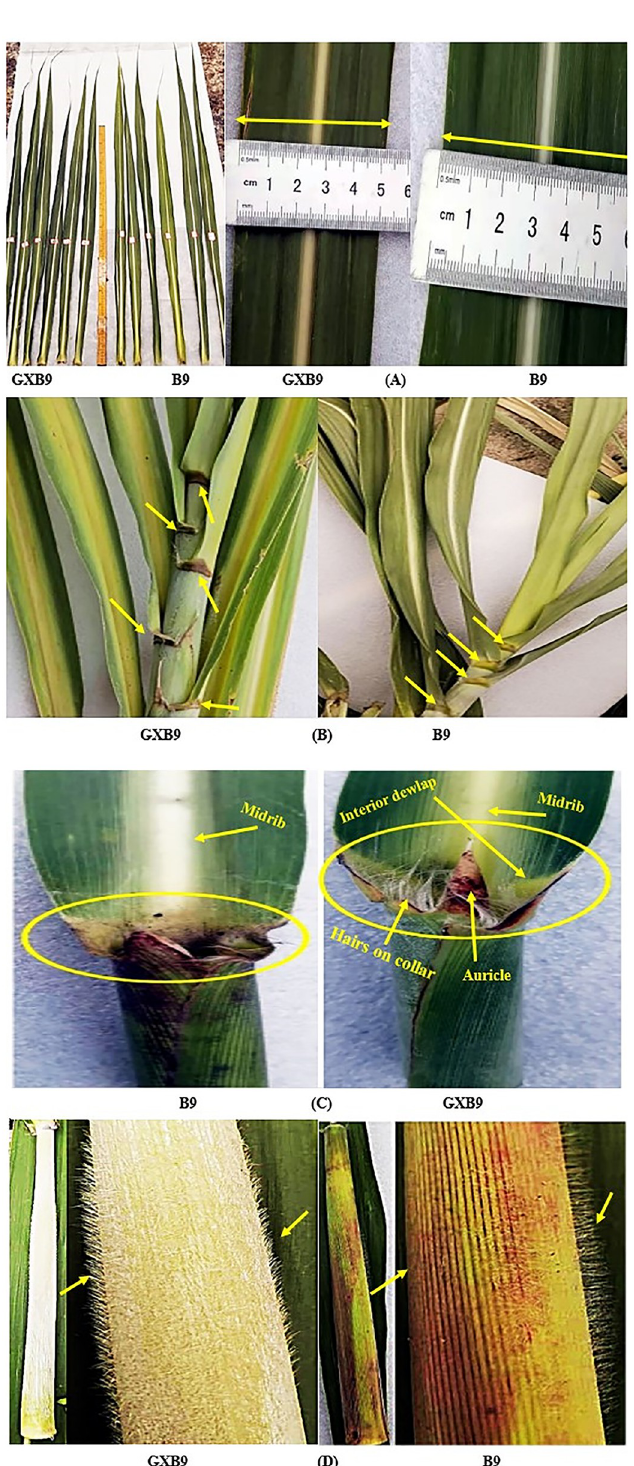
Fig 5. Leaf structures in GXB9 and B9. A , leaf length and width; B , ligule color; C , leaf auricle, collar hairs and dewlap; D , leaf sheath wax, spines and color.